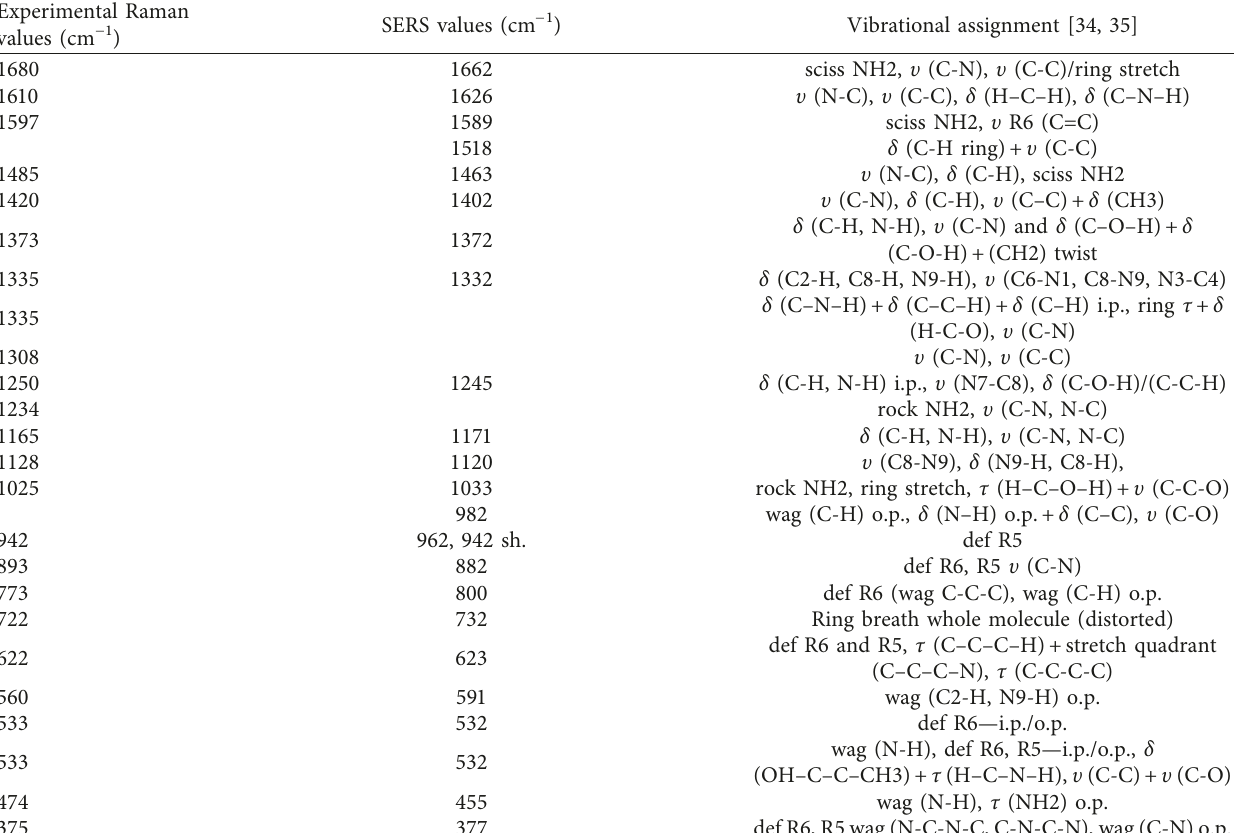
1 ) for aqueous solution of −